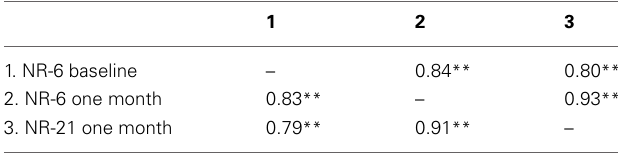
Table 4 | Study 4—test-retest correlations—baseline to one month for nature relatedness 6-item and 21-item